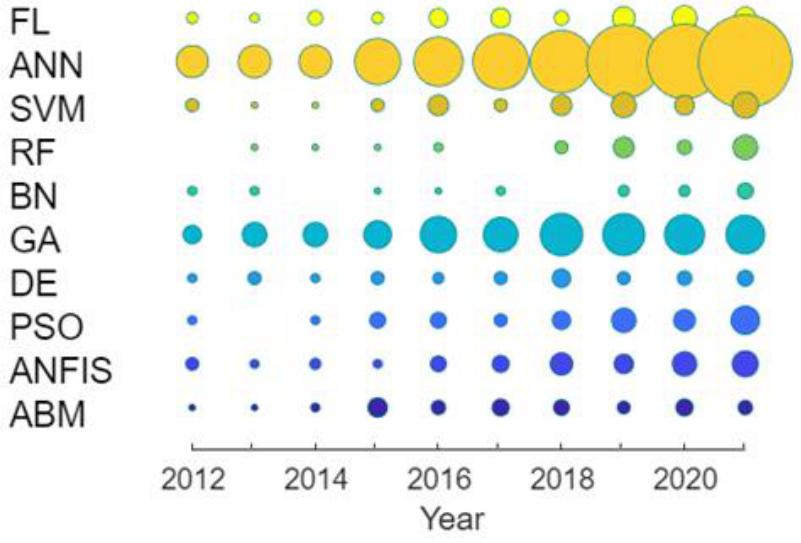
Figure 11. A graph showing the varying use of AI keywords in bioenergy research from 2012 to 2021. FL: fuzzy logic; ANN: artificial neural network, SVM: support vector machine, RF: random forest, BN: Bayesian network, GA: genetic algorithm, DE: differential evolution, PSO: particle swarm optimisation, ANFIS: adaptive neuro-fuzzy inference system and ABM: agent-based model.